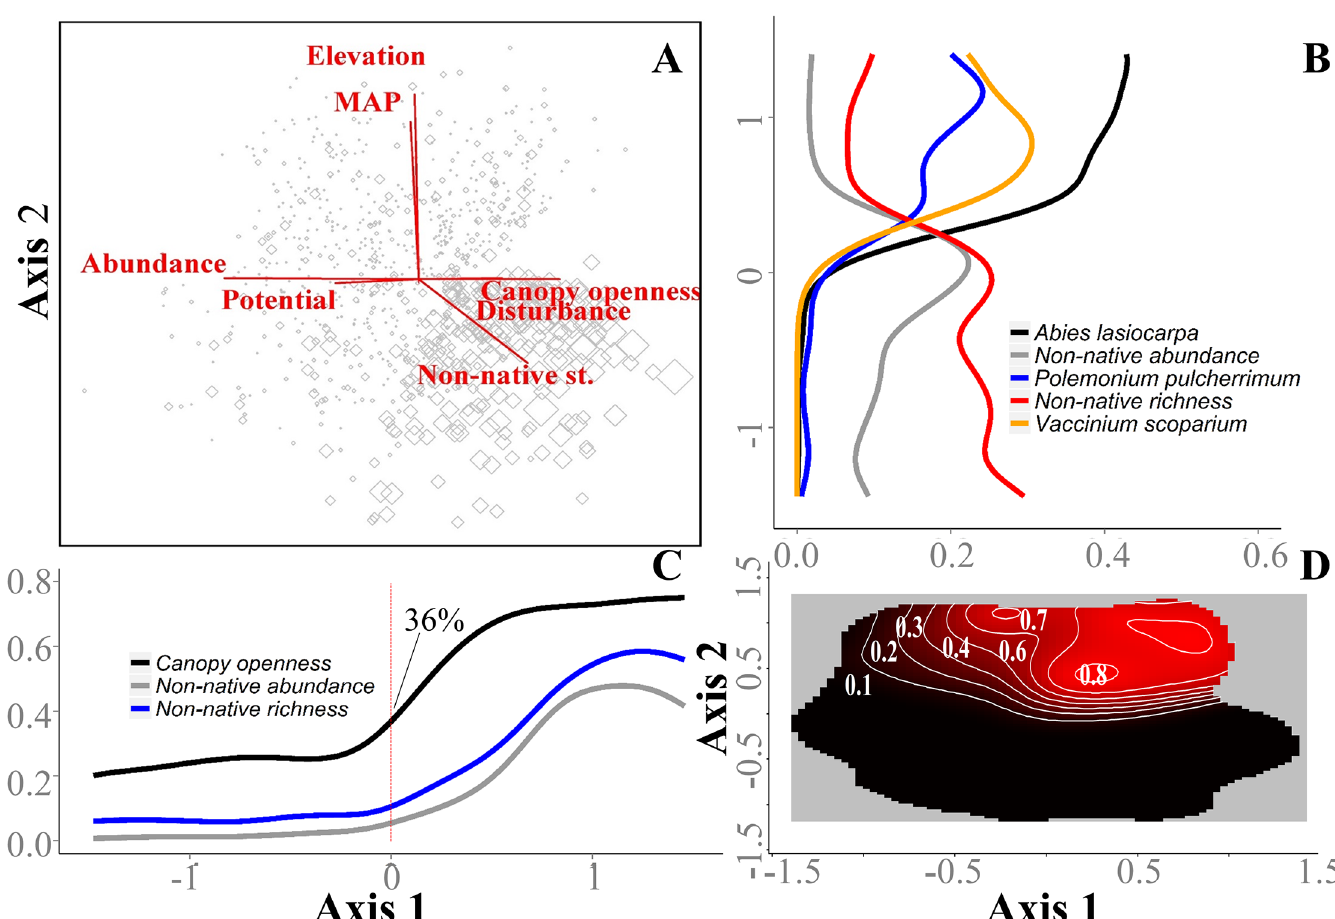
Fig 4. Subalpine community and canopy openness transitions in NMS ordination space. A) NMS ordination of sample units (open diamonds; size corresponds to the abundance of non-native species in each sample unit) in species space (rotated to load canopy openness on Axis 1) and strongly related environmental/trait factors. The combined distance matrix variance represented is 60%, with 30.6% and 29.4% being represented by Axes 1 and 2, respectively. B) subalpine indicator species and non-native richness and abundance responses (NPMR derived) to NMS Axis 2; C) canopy openness and non-native richness and abundance responses (NPMR derived) to NMSAxis 1; B and C) Response variables were relativized by maximum values. D) NPMR derived 3-dimensional contour plot depicting density of subalpine plot sampling in species space. MAP (mean annual precipitation); Non-native st (percent non-native cover relative to total cover); Abundance (observed abundance; sum of cover for a species in all subplots); and Potential (abundance potential; maximum abundance for a species in any subplot).